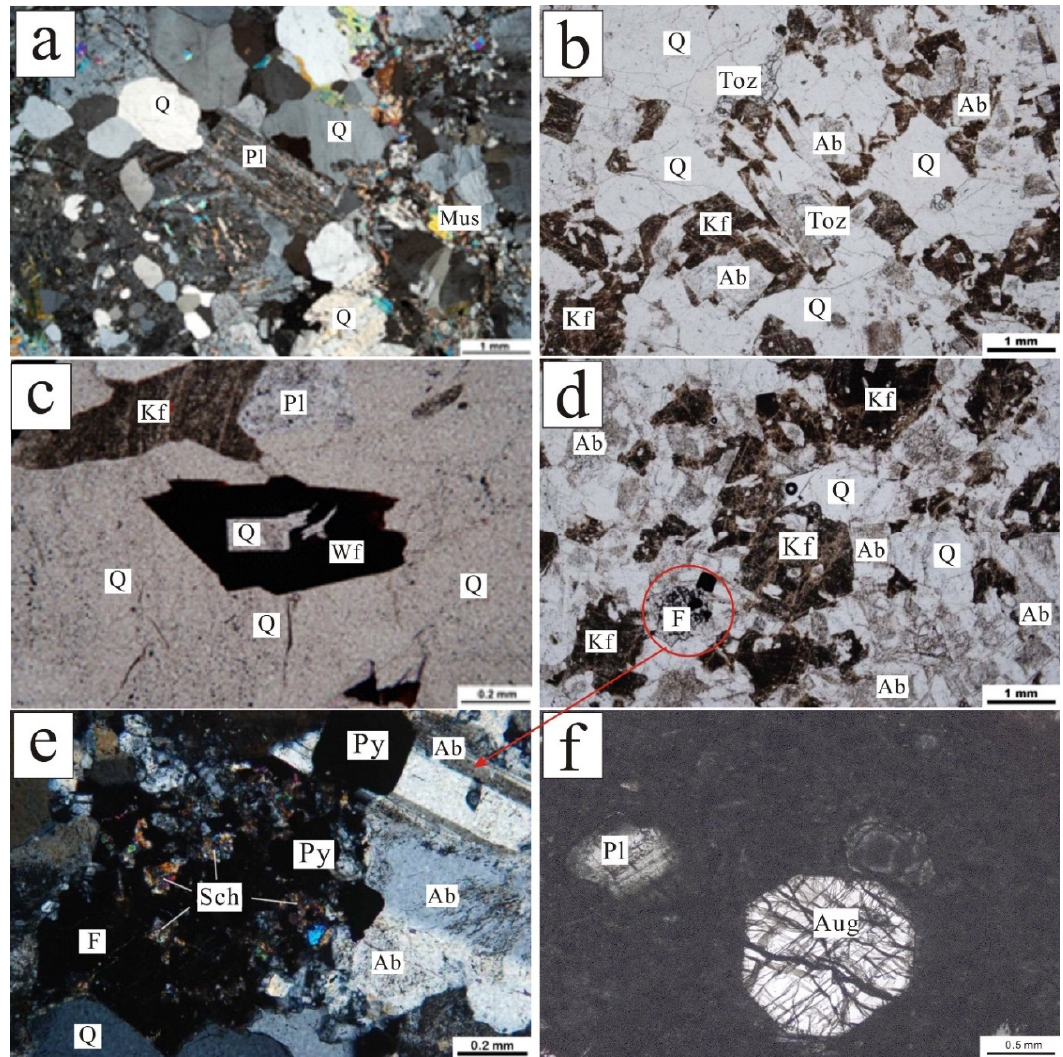
Figure 4. Microphotographs of rocks of the Qianlishan complex: ( a ) porphyritic granite; ( b , c ) equigranular granite; ( d , e ) granite porphyry; and ( f ) mafic dyke. Abbreviations: Pl: plagioclase; Q: Quartz; Mus: Muscovite; Kf: K-feldspar; Toz: topaz; Wf: Wolframite; F: Fluorite; Sch: scheelite; Py: pyrite; and Aug: augite.